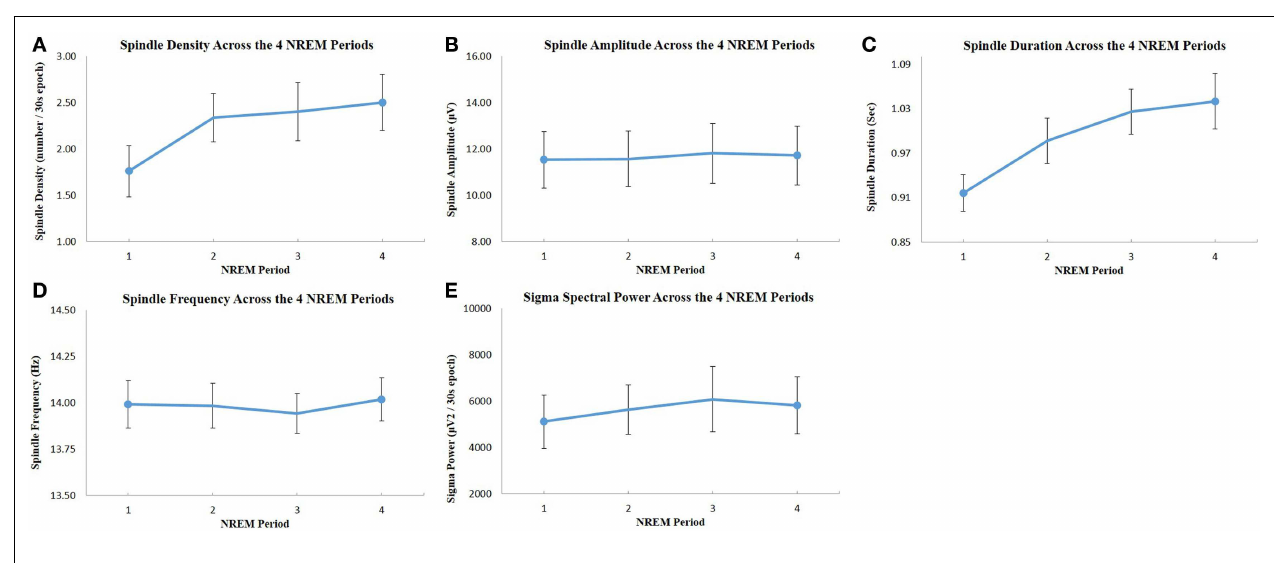
and the bars show the standard error of the mean.There was a significant increase of spindle density and duration across NREM sleep periods (one-way repeated measures ANOVA, p < 0.05), but there was no significant change of spindle amplitude, frequency, and sigma power across